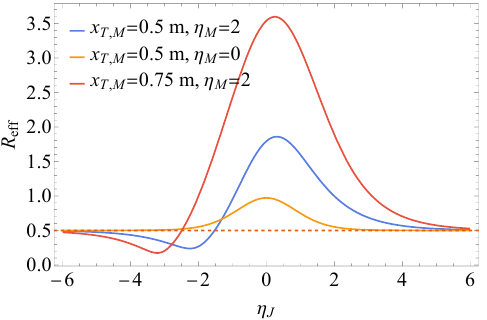
Figure 5 . The effective radius, R eff , as a function of η J with x T,M = 0 . 5 m and η M = 2 (blue solid line), x = 0 . 5 m and η = 0 (yellow solid line), and x T,M M line). A fixed value of 0.5 is also shown (red dashed line).